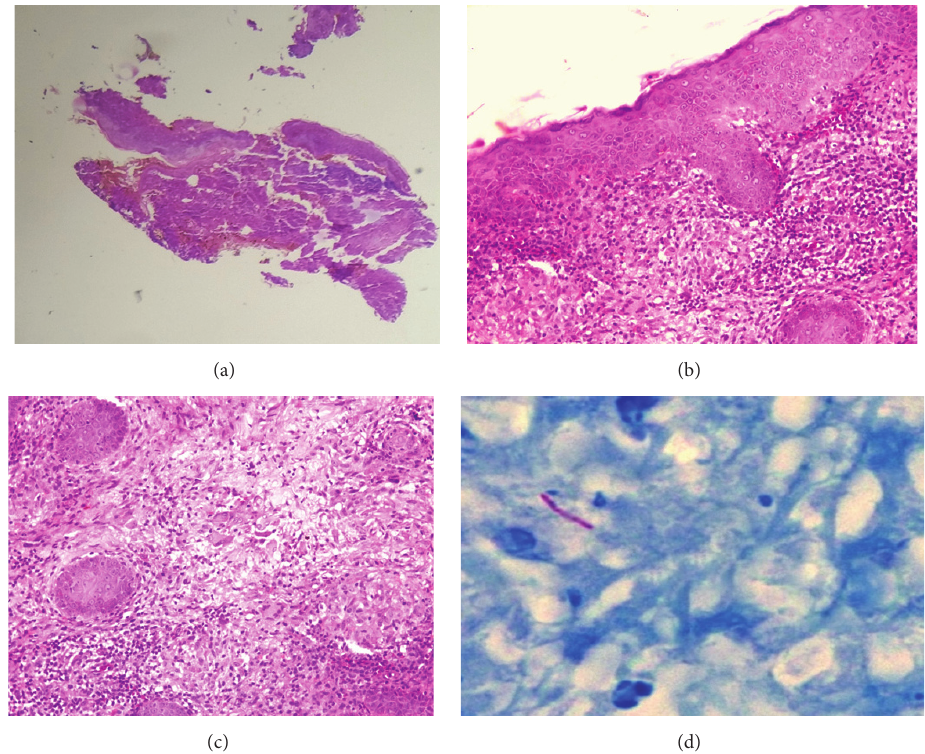
Figure 2: (a) Pseudoepitheliomatous hyperplasia with hyperkeratosis and acanthosis [H and E (40x)]. (b) Pseudoepitheliomatous hyperplasia with hyperkeratosis and acanthosis [H and E (400x)]. (c) Dense inflammatory infiltrates with epithelioid cells and giant cells in the dermis [H and E (400x)]. (d) Ziehl-Neelsen Staining showing scant AFB [ZN Staining (1000x)].